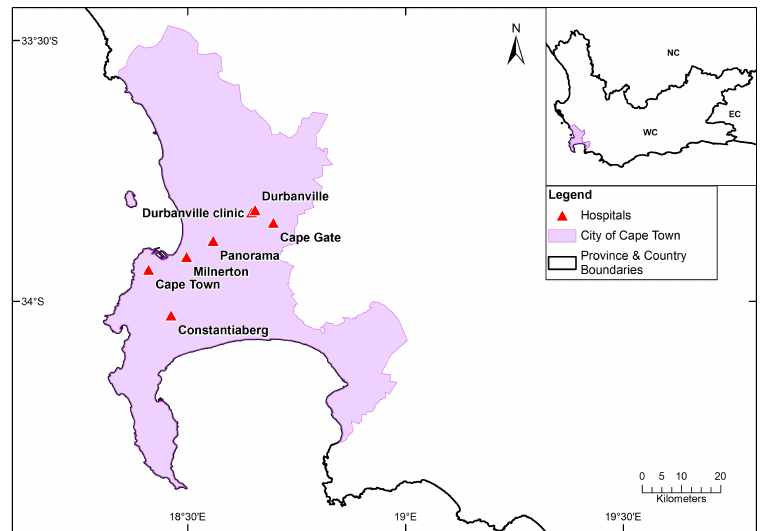
Figure 1. The location of the private hospitals in the City of Cape Town region that were considered in the